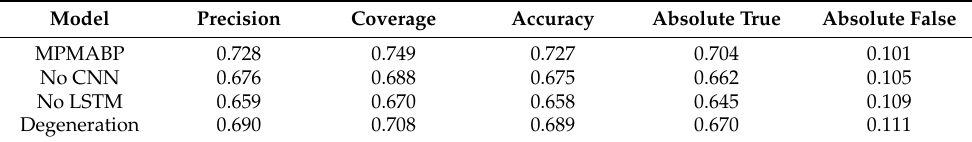
Table 8. The predictive performance of the independent